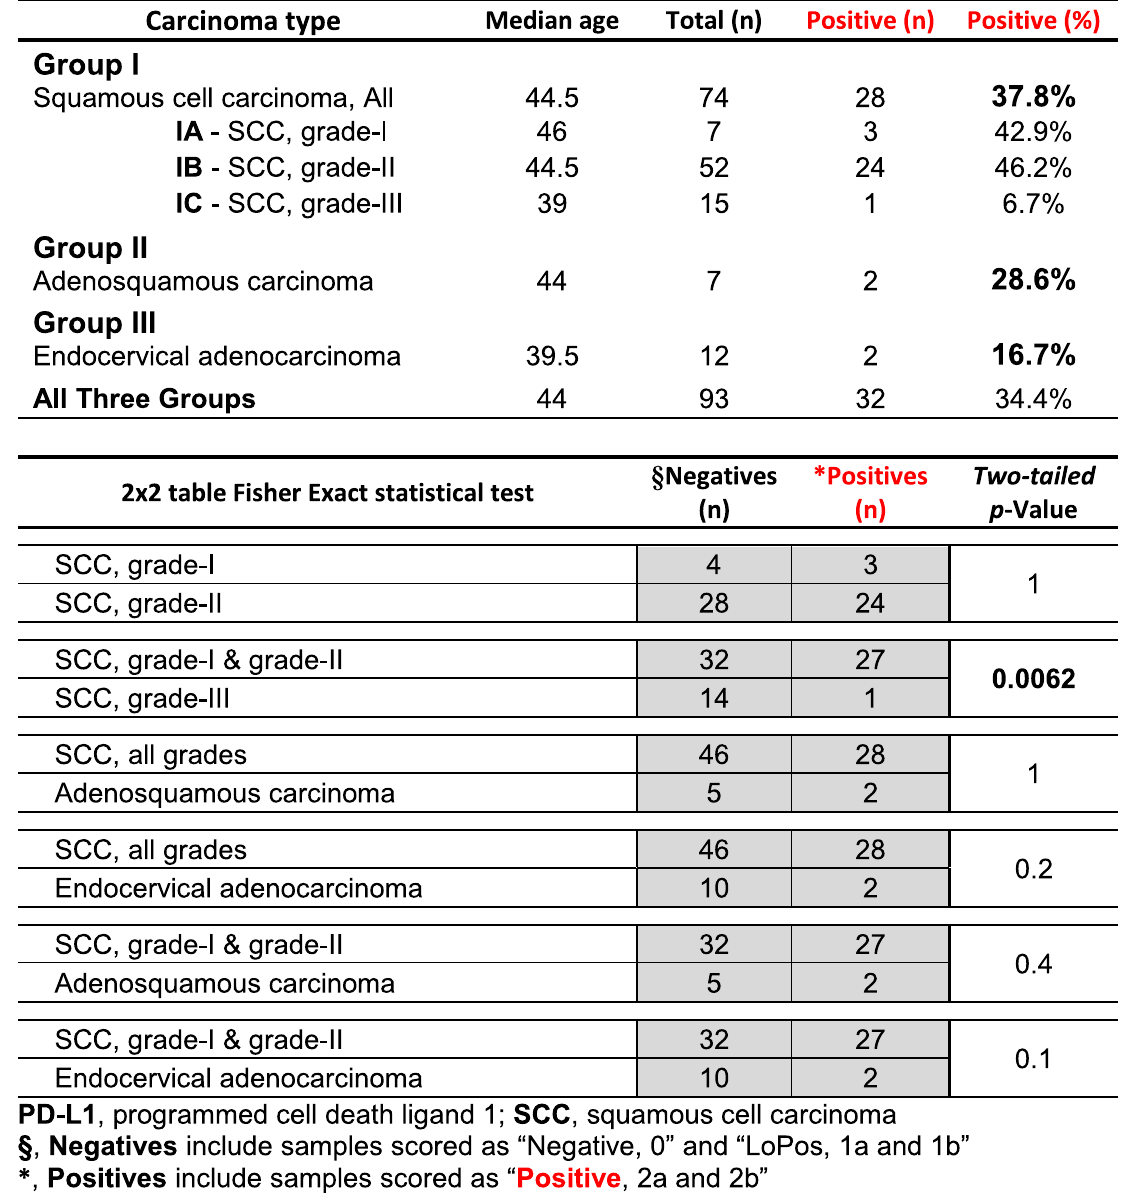
Table 6 Summary of the cases with Score-3 PD-L1 positivity in the different groups and subgroups of the uterine cervical carcinomas